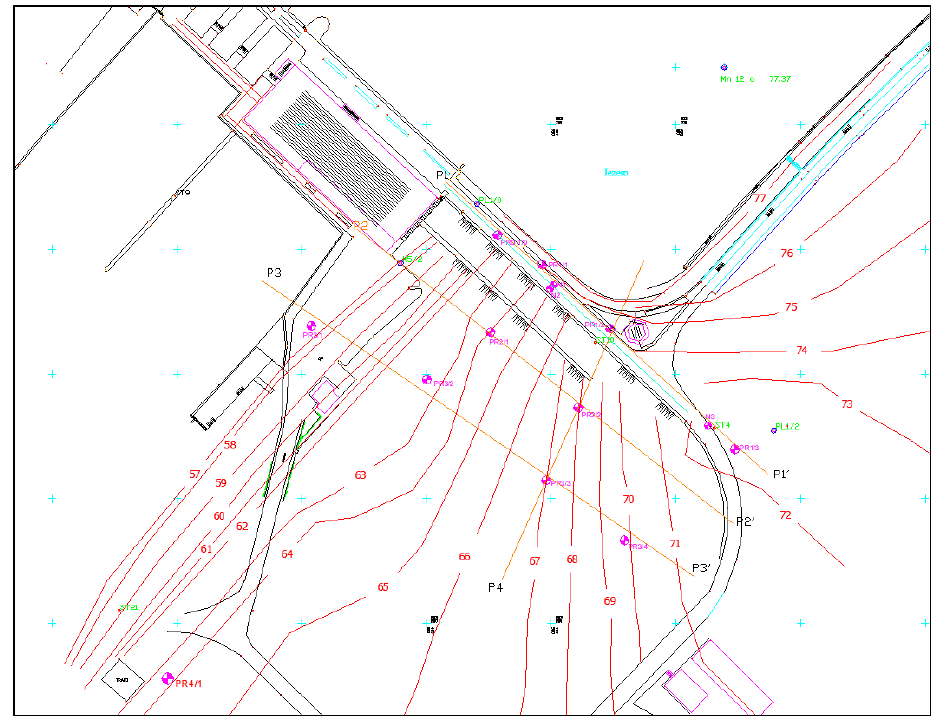
Figure 8. Equipotential lines of the groundwater level around the HEPP Mostar dam [15].